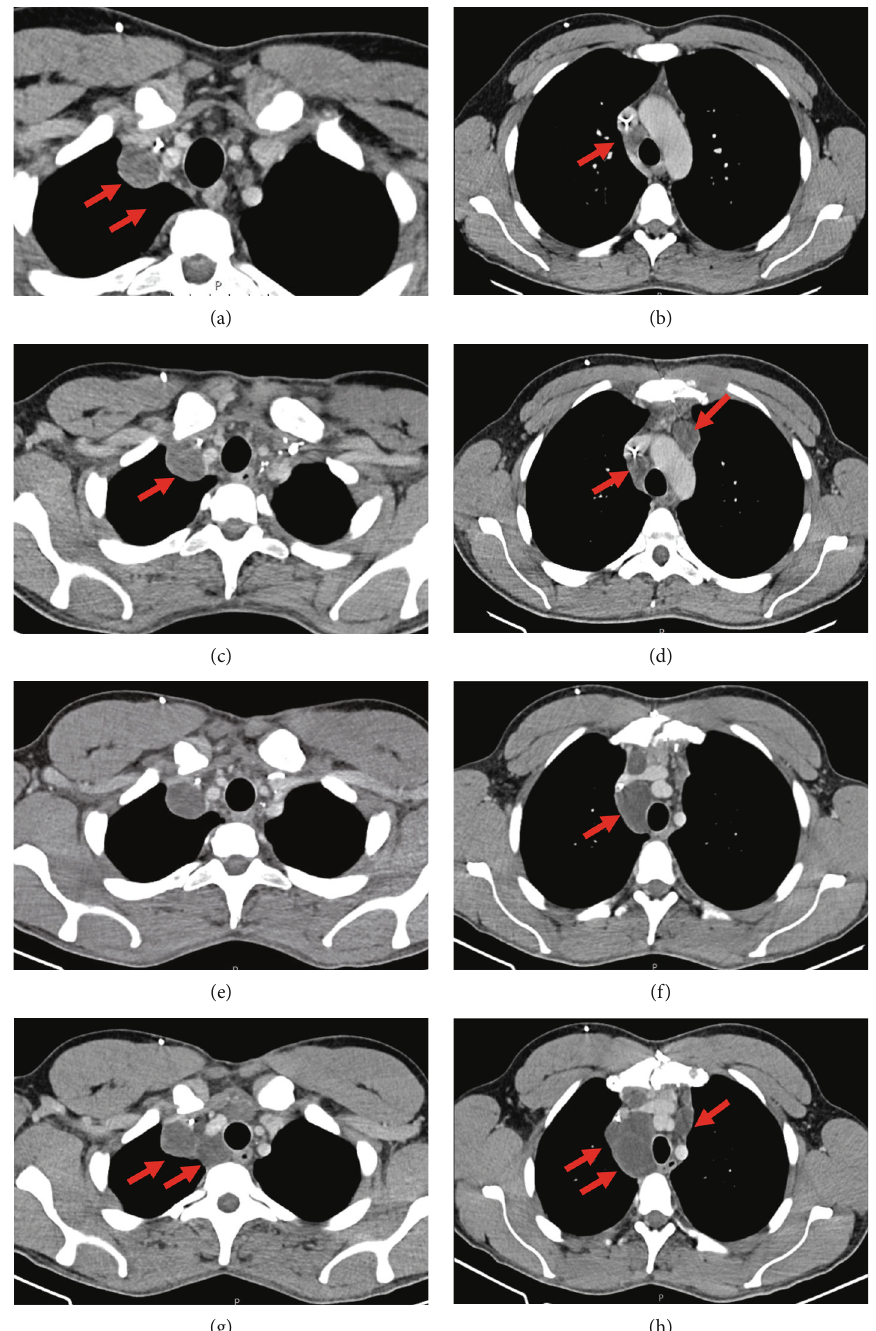
Figure 7: CT images. Axial thoracic contrast-enhanced CT images on two di ff erent mediastinal levels at 5-month (a, c), 7-month (c, d), 12- month (e, f), and 24-month (g, h) follow-up, depicting enlarging hypodense lymph